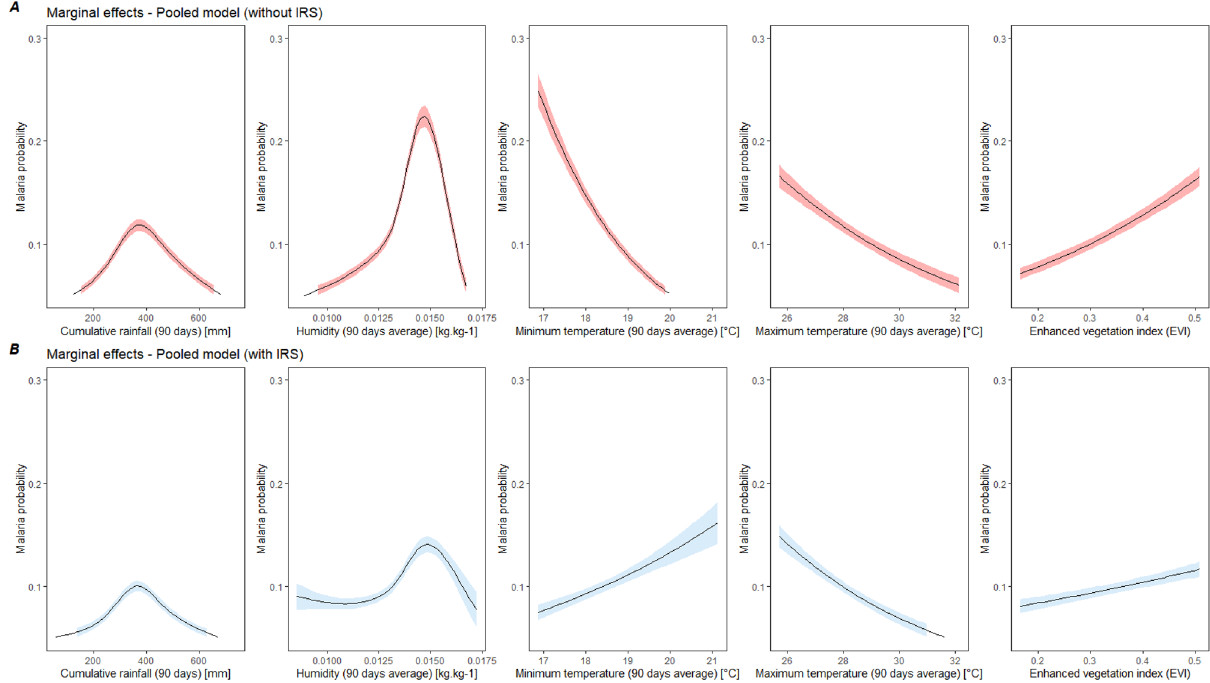
Figure 2. Marginal effect of environmental variables on malaria risk from global GLMM model not controlling for IRS ( A ) and controlling for IRS ( B ). Models without interventions include maximum and minimum temperature, rainfall, humidity, EVI, age at visit, sex, housing type, household wealth index, number of persons living in the house, number of meat meal. Models with intervention additionally include the spraying variable.